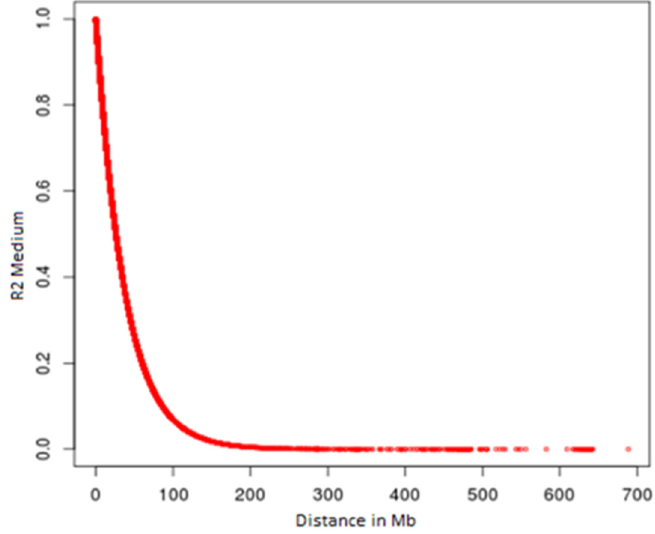
Figure 4. Break in r 2 levels with the increase distances between markers.